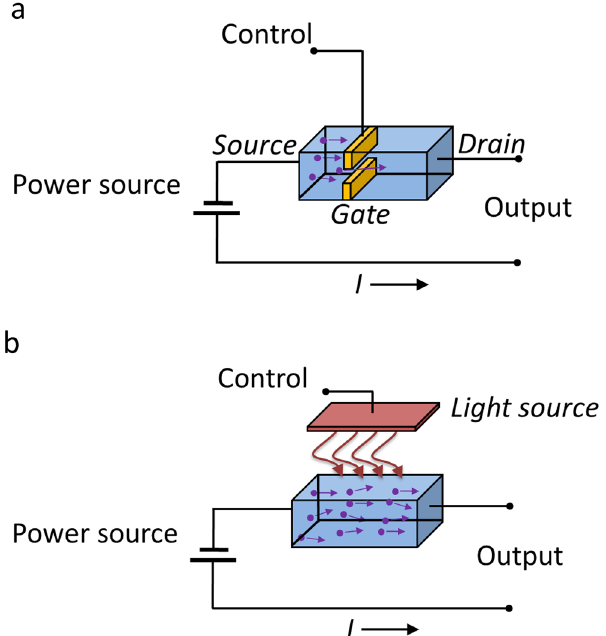
Figure 1. Highly simplified junction field effect control contrasted with bulk photonic control. ( a ) Charge carriers flow from the source to drain and are controlled by the field at the gate. The time delay from the action at the gate to a response at the drain is limited by the carrier drift speed. The slower the response, the greater the energy wasted. Poorer energy efficiency and difficulty in stacking to high voltage DC (HVDC) transmission result because of gate isolation requirements. ( b ) Direct control of carriers in the bulk by photons using below bandgap excitation creates carriers instantaneously in the bulk. The time delay from the action at the optical source to a response at the output is limited only by the light source and the conglomerative effects of the recombination dynamics. Greater energy efficiency and the ability to stack to HVDC result from the light